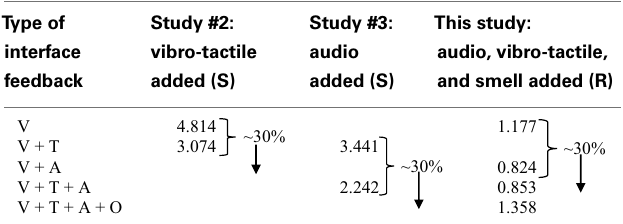
Table 8 |The same drop in the median number of collisions that was detected in studies using simulated robots was also detected with the real robot